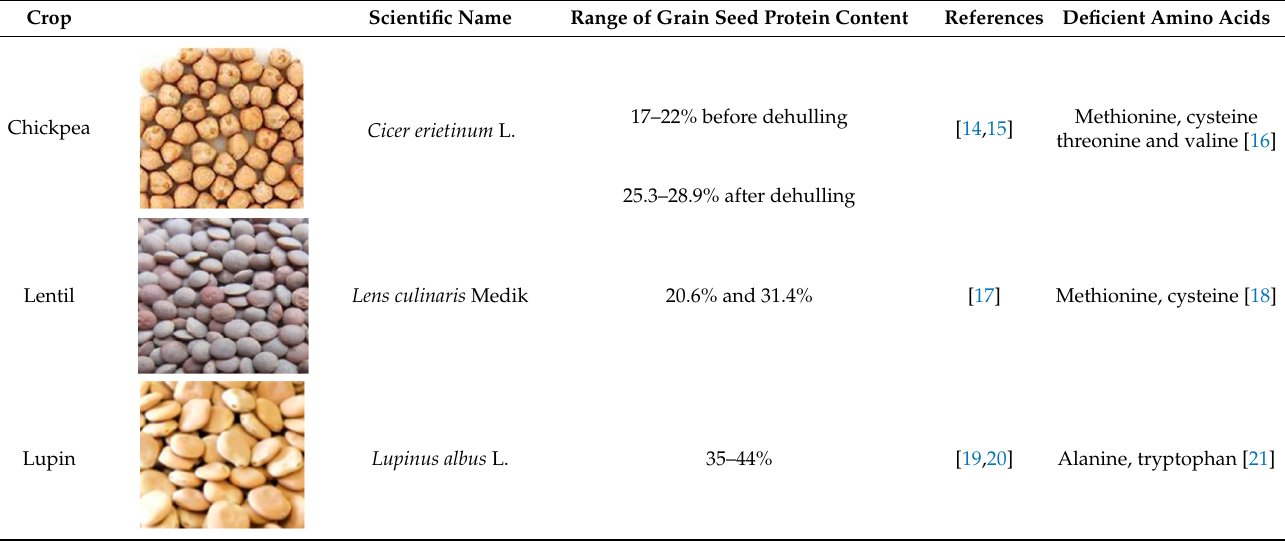
Table 1. Seed protein contents and deficient amino acids in major grain legumes.